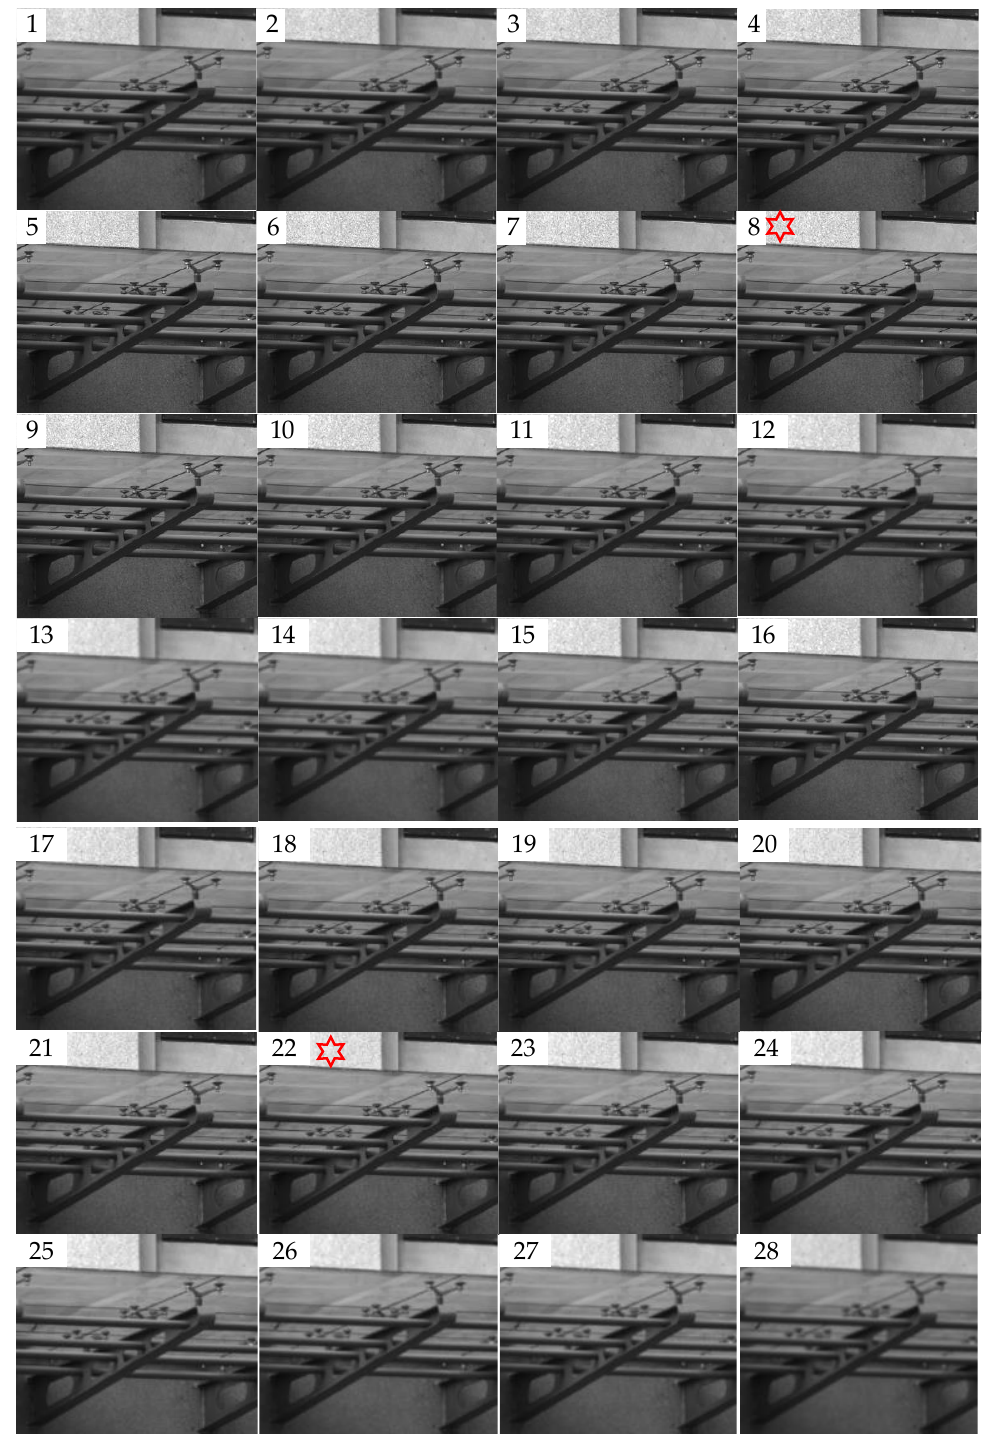
Figure 7. Dual-peak defocused image sequence (1 – 28). The shooting process is defocus, focus, defocus, focus, and defocus respectively. Image 8 and image 22 are in focus.